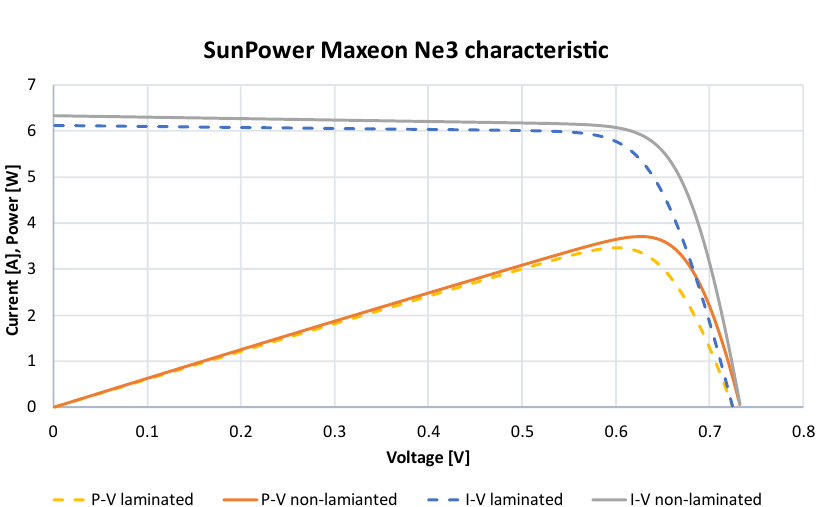
Figure 9. I–V and P–V characteristics of the SunPower Maxeon Ne3 Figure 9. I – V and P – V characteristics of the SunPower Maxeon Ne3 cells.